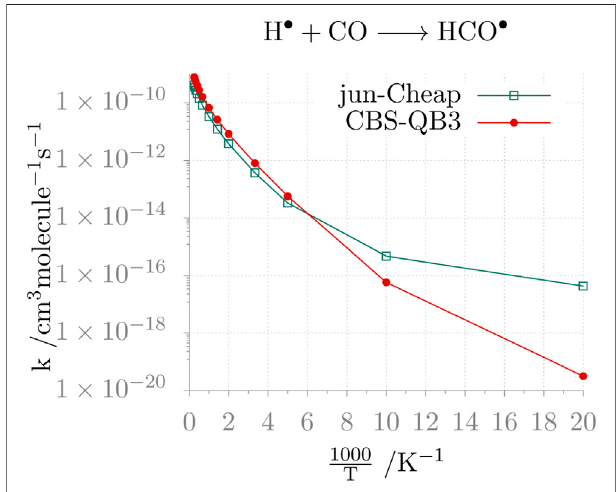
(cid:129) + CO reaction rate